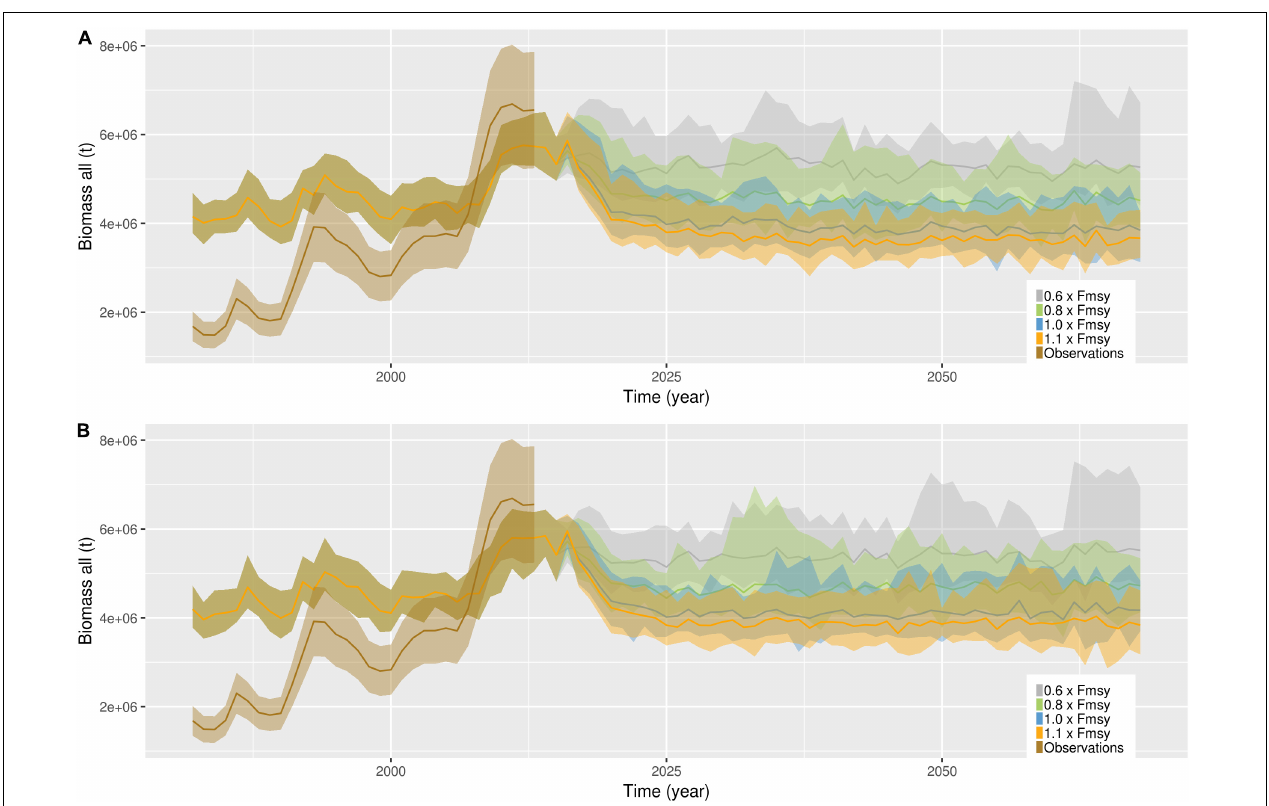
FIGURE 4 | Temporal development of demersal biomass (biomass of cohorts included in the assessment) in the four scenarios only including commercial fish (A) and in the four scenarios including additional harvest on mesopelagic fish, other demersal, large demersal, zooplankton and small pelagic fish (B) . Brown (transparent) is observations of total biomass from assessment reports, including 20% uncertainty. Gray line represents global sustainability, green represents world market, blue represents local stewardship and orange represents national enterprise scenario. The shading represents one standard deviation from the mean of the 14 different simulations representing each scenario.